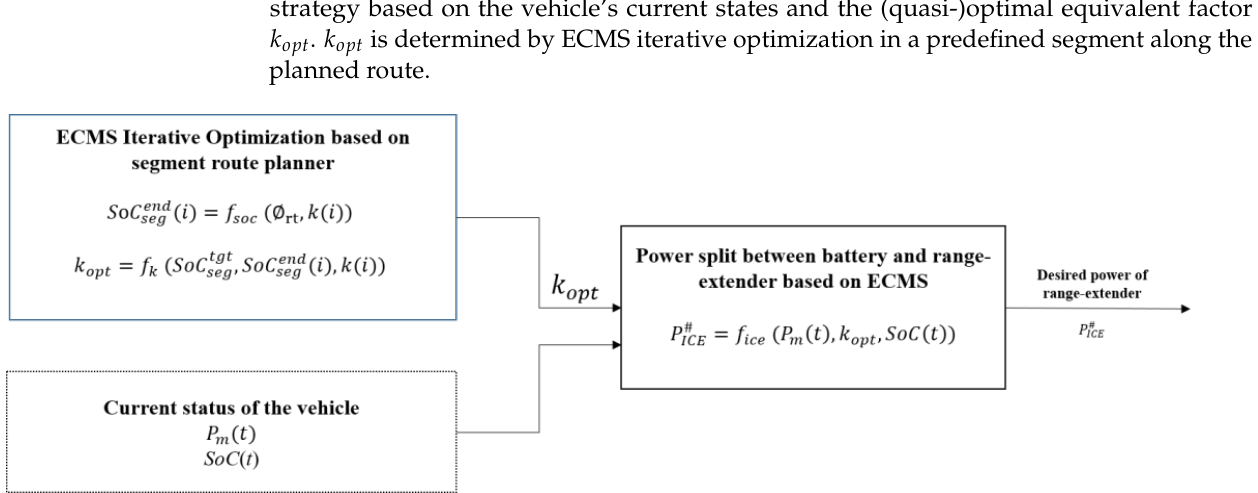
Figure 8. Logical structure diagram of the A-ECMS strategy.